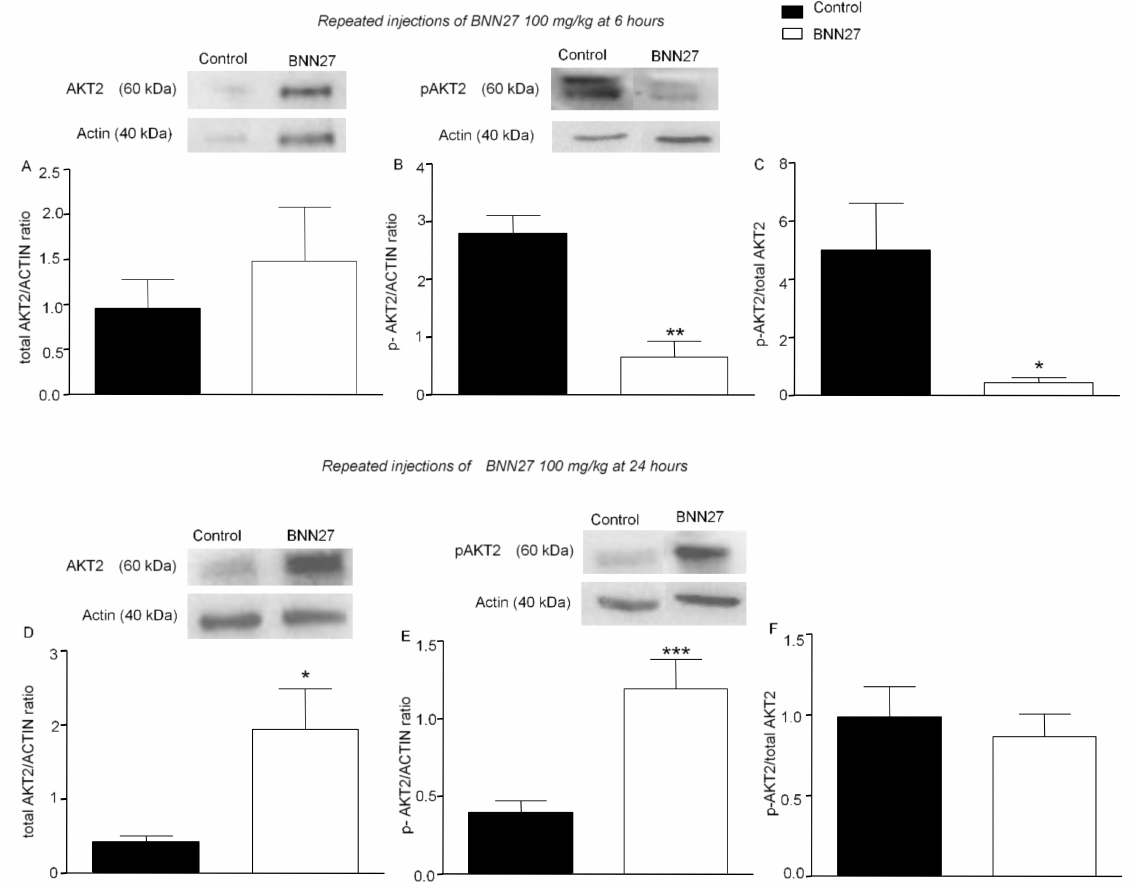
Figure 6. BNN27 affected AKT2 phosphorylation in the inflamed paw. Repeated injections of BNN27 100 mg/kg decreased AKT2 phosphorylation at 6 h but had no effect on total AKT2 ( A – C ). At 24 h, BNN27 increased the expression of total ( D ) and p-AKT2 ( E ) but the overall AKT2 phosphorylation was unchanged ( F ). ( A ) Control group n = 4 mice, BNN27 treated group n = 4 mice; ( B ) Control group n = 3 mice, BNN27-treated group n = 3 mice; ( C ) Control group n = 3 mice, BNN27-treated group n = 3 mice; ( D ) Control group n = 4 mice, BNN27-treated group n = 4 mice; ( E ) Control group n = 4 mice, BNN27-treated group n = 3 mice; ( F ) Control group n = 3 mice, BNN27-treated group n = 3 mice. In all panels * p < 0.05, ** p < 0.01, *** p < 0.001. Statistical analysis was performed using unpaired t -tests. All data are expressed as the mean ±